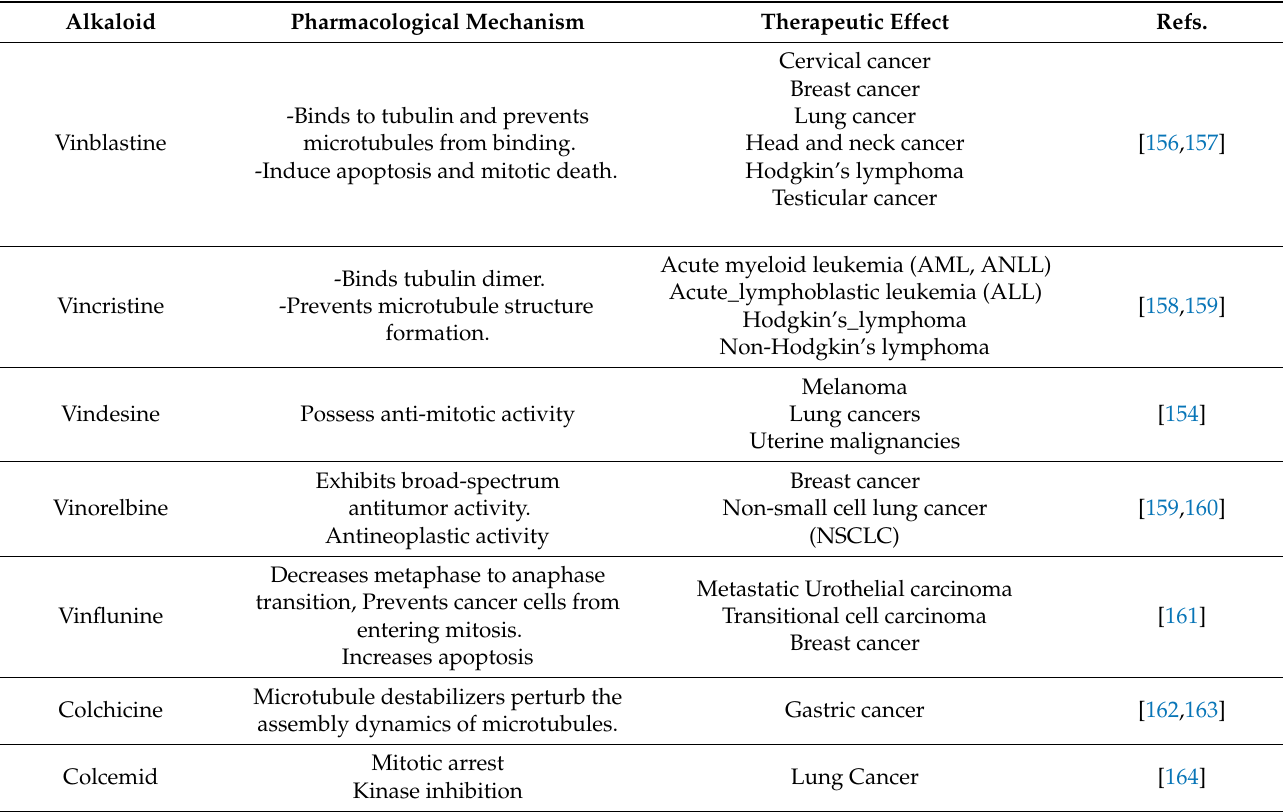
Table 3. Alkaloids and their therapeutic effect and pharmacological